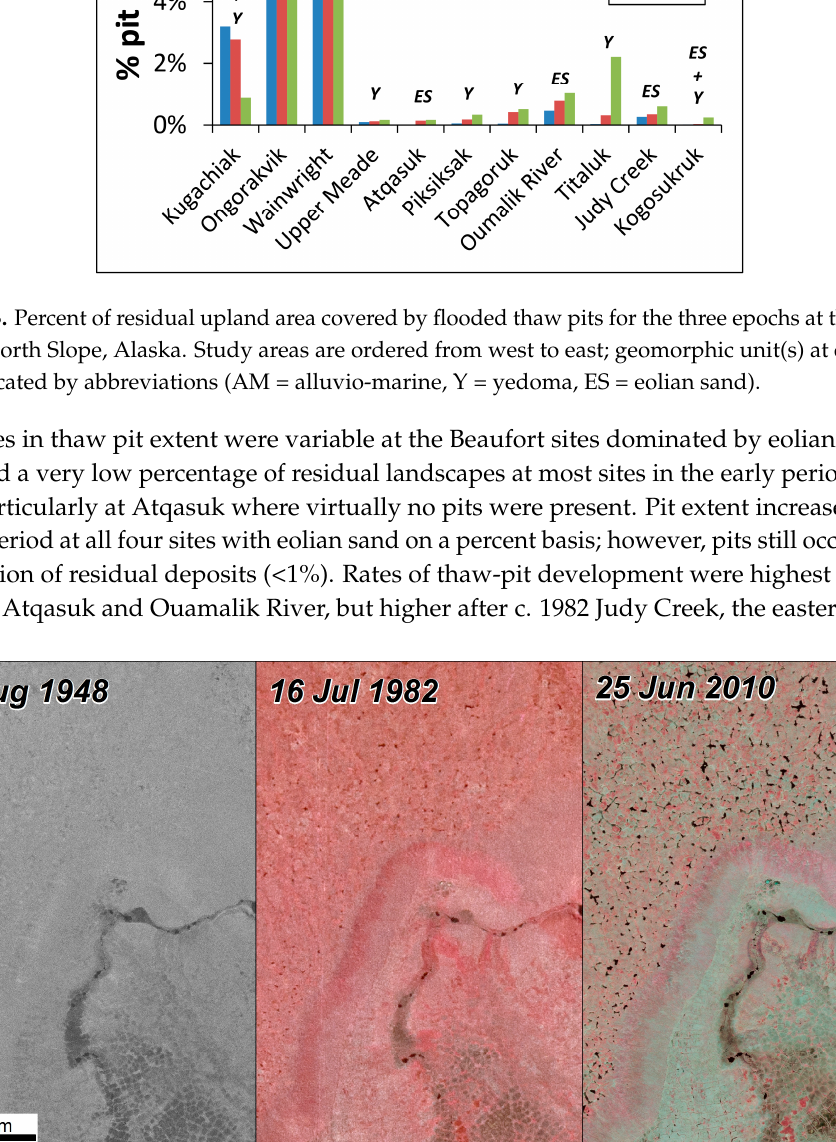
Figure 4. Recent onset of ice-wedge degradation in yedoma uplands at Titaluk site in the Arctic foothills, 1948–2010, North Slope, Alaska.